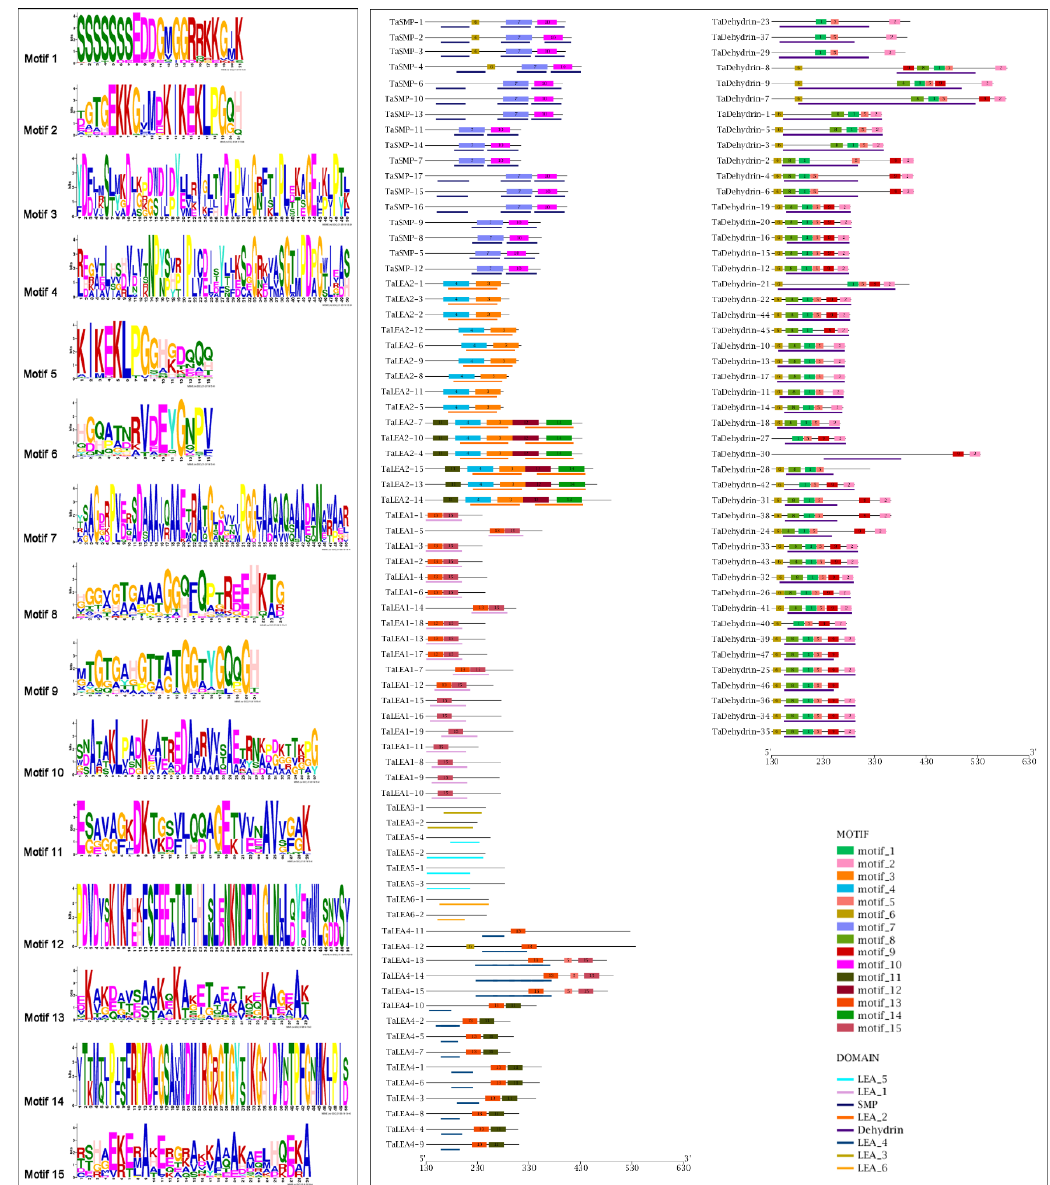
Figure 3. Conserved motifs ( left ) and their distributions ( right ) of TaLEA genes predicted by the MEME (Multiple Expectation Maximization for Motif Elicitation) online tool. Each motif is represented by a different colored box with corresponding number. The domain of each subfamily is represented by a different colored thick line below.